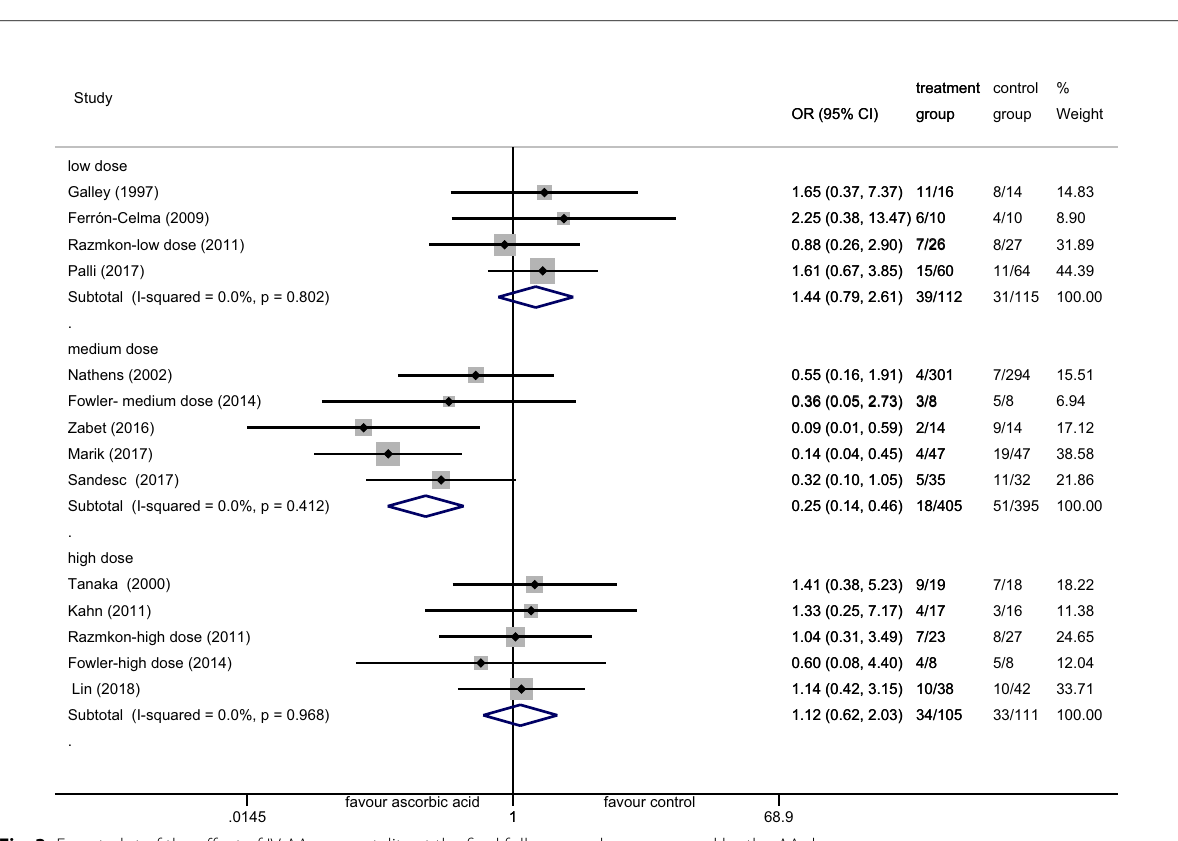
Fig. 3 Forest plot of the effect of IV AA on mortality at the final follow‑up when compared by the AA